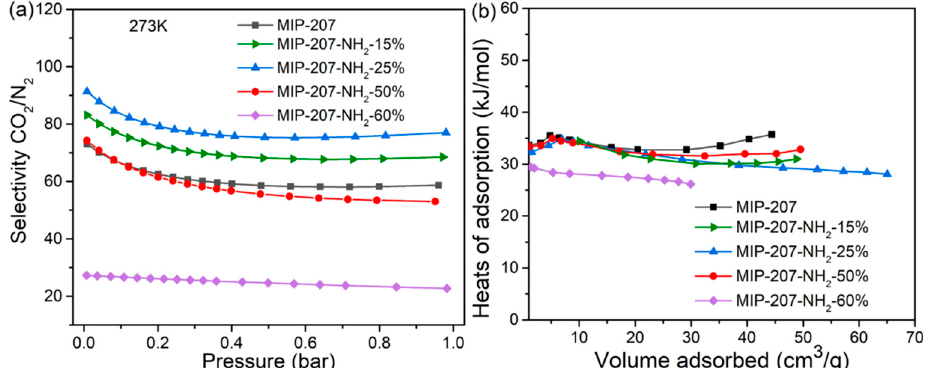
Figure 5. ( a ) CO 2 /N 2 selectivity at 0 °C and ( b ) CO 2 adsorption enthalpy curves.